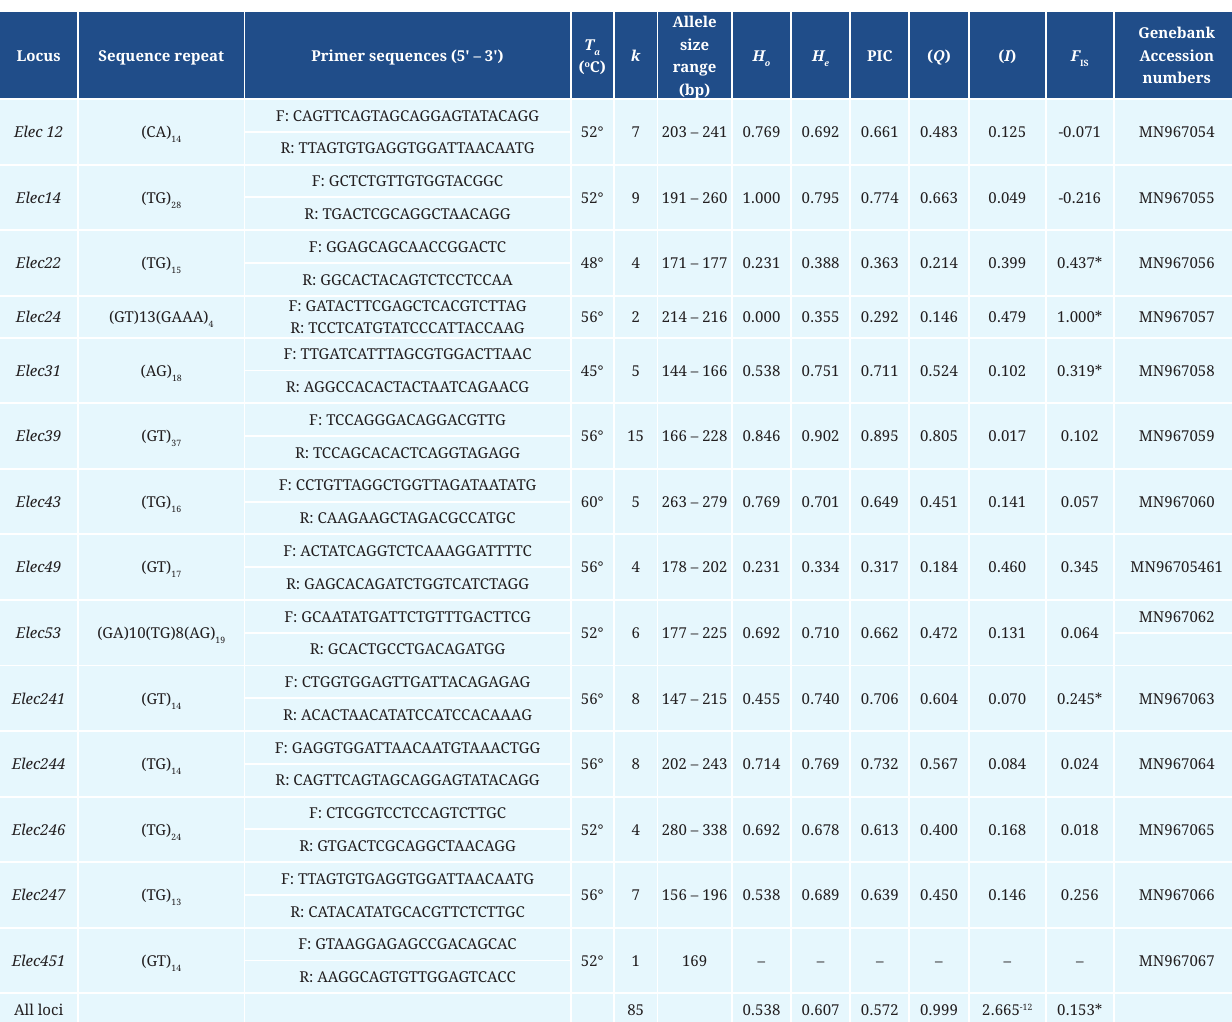
TABLE 1 | Description and characterization of 14 microsatellite loci isolated from Electrophorus varii . Flanking primers, Ta = optimal annealing temperatures, k = number of alleles, H Q = paternity exclusion probability, I = probability of genetic identity, F GenBank accession numbers. * Significant value for the endogamy coefficient ( F